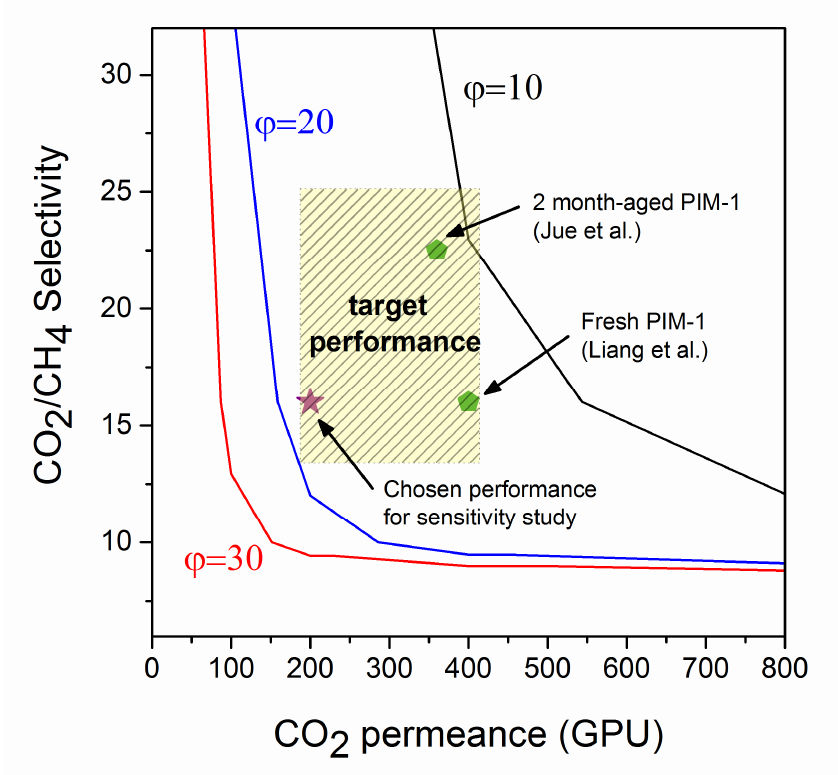
Figure 8. Summary of the feasibility of the hybrid process at various membrane performances (CO 2 permeance and CO 2 /CH 4 selectivity and three different studied pressure ratios of 10, 20, and 30 (represented as lines). Any points to the right-hand side of the lines are when the hybrid process becomes more feasible than the stand-alone amine process. Data points for PIM-1 membranes reported in the literature (fresh [37] and aged for 2 months [35]) are included).